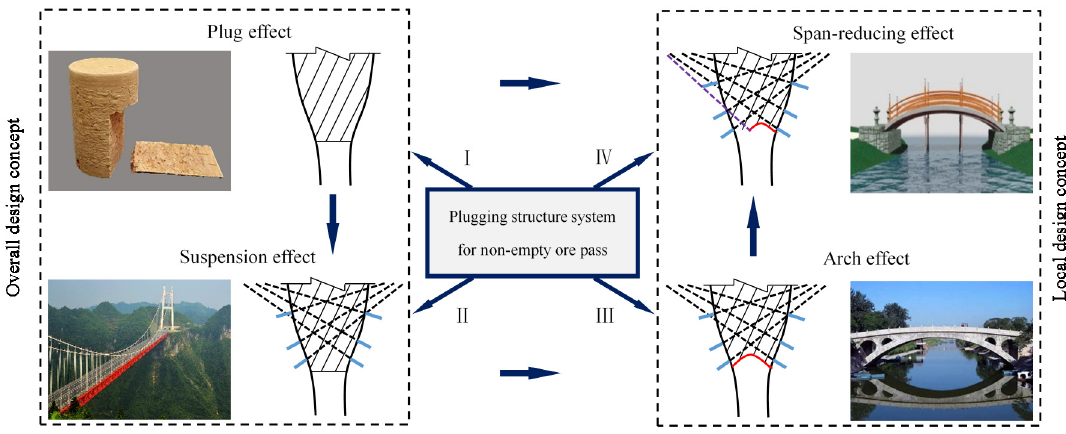
Figure 1. Structure-plugging system for an ore pass in the non-empty condition.